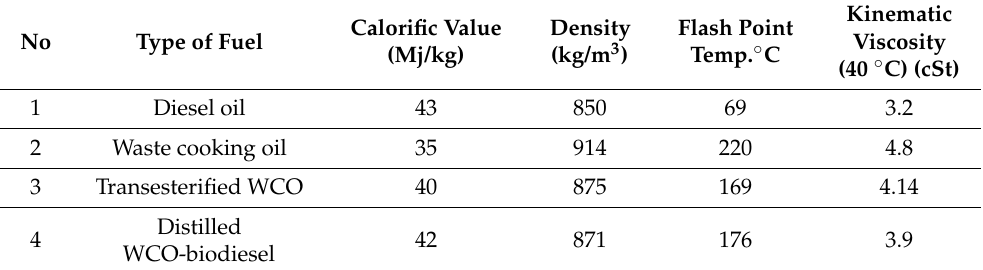
Table 3. Properties of